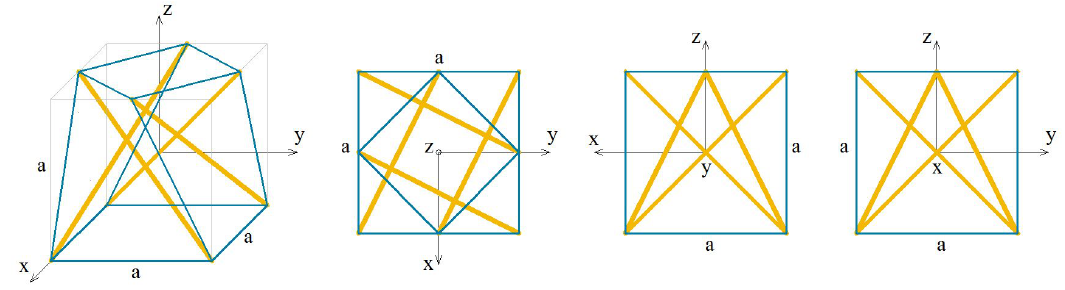
Figure 4. Geometry of the 4-strut simplex module.